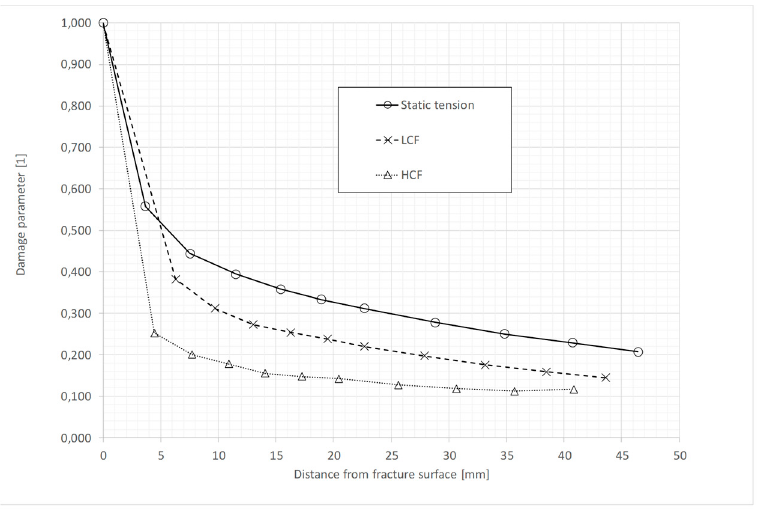
Figure 7. Distribution of the damage parameter in the gage part of the specimens after